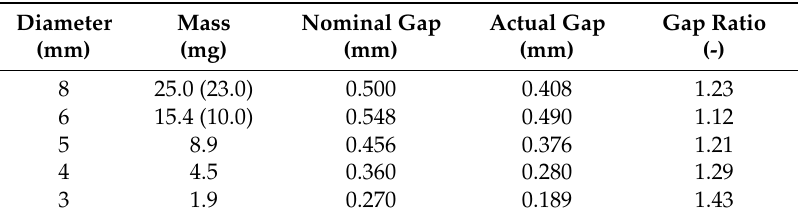
Table 1. Diameter, mass, and gap of the samples. The values in parenthesis refer to nonlinear tests. The mass was weighed at 25 ◦ C. The actual gap was measured at 150 ◦ C. The uncertainty for mass is ± 0.1 mg, and for the actual gap ± 1 µ